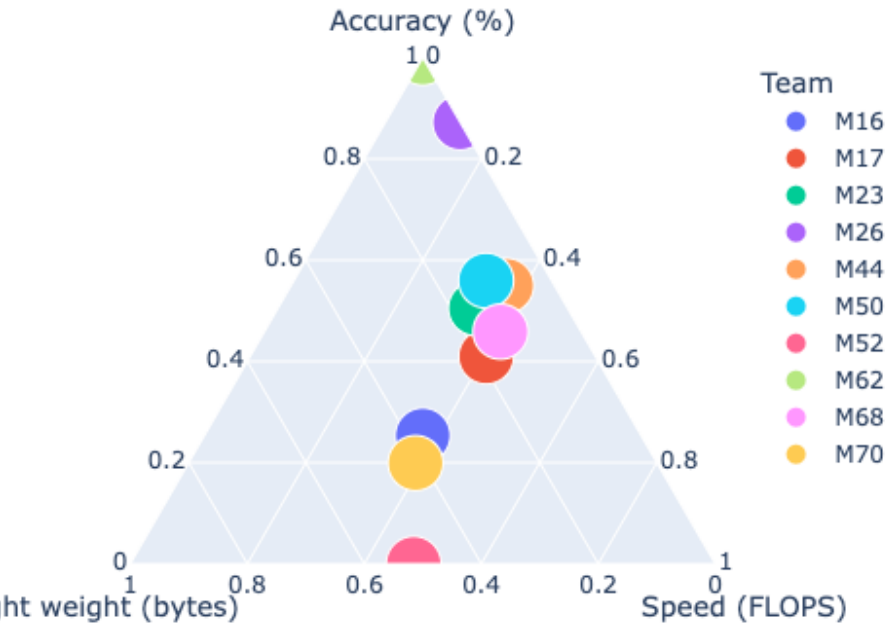
Figure 6. Ternary diagrams for top 10 models performance based on accuracy, lightweightness, and